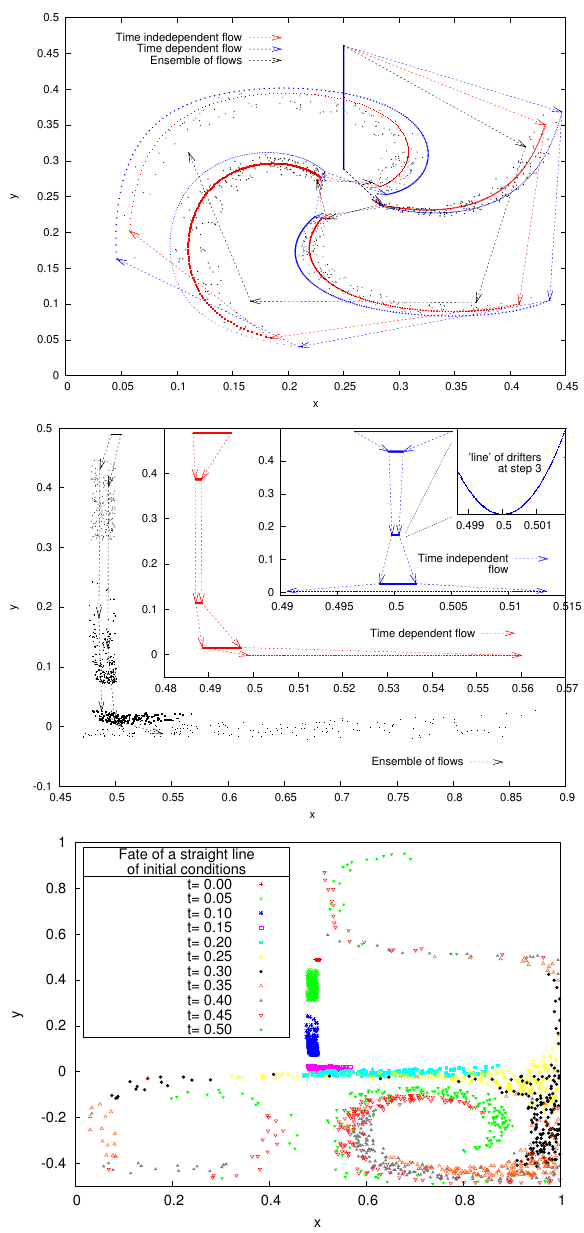
Fig. 2. The effect of shear and saddle on an ensemble of initial conditions of the Lagrangian drifter near a centre at ( x,y ) = (0 . 25 , 0 . 25) (top panel) and near the saddle at ( x,y ) = (0 . 5 , 0 . 5) with separatrices x = 0 . 5 and y = 0 . 5 (middle panel). The divergence of trajectories starting near the saddle, within a time span of 0 . 50 in an ensemble of velocities, is shown in bottom panel.